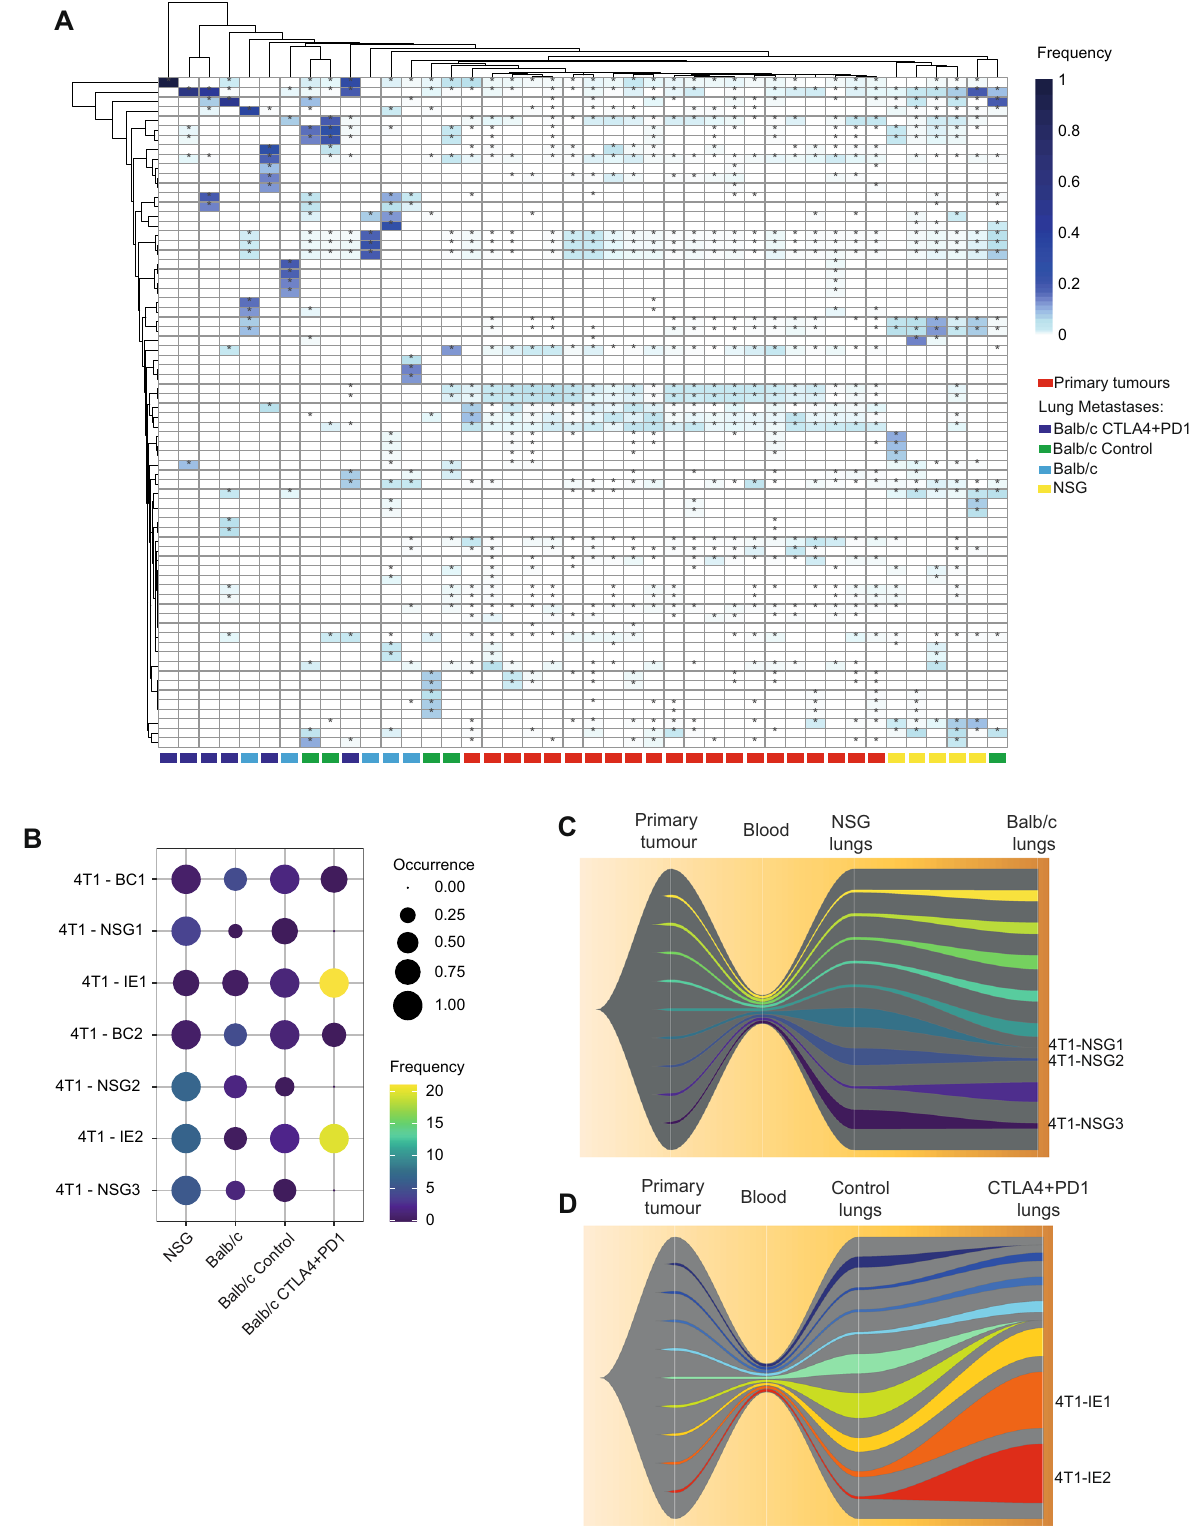
Fig. 4 | Analysis of speci fi c barcodes enriched or depleted by the immune system and immunotherapy in the 4T1 model. A Unsupervised hierarchical clustering heatmapofbarcodeswithanabundanceofabove5%inatleastone4T1primarytumourorlungmetastasissample;*indicatebarcodesdetectedatafrequencyabove0.1% inaparticularsample.Eachcolumnrepresentsasample(lungorprimarytumour)andeachrowrepresentsabarcode. B Dotplotofasubsetofspeci fi cbarcodes.Fivemice pergroup.Eachrowrepresentsabarcode.Eachcolumnrepresentsamousestrainortreatmentgroup. C Fishplotoftheninemostabundantbarcodesdetectedinlungsof WT and NSG mice, each of these nine barcodes is given a unique colour with the remaining barcodes being combined and represented in grey. A bottleneck has been introducedbetweenprimarytumourandlungmetastasestodepictthetransitionthroughthebloodstream. D Fishplotoftheninemostabundantbarcodesdetectedinthe lungsofWTmicetreatedwithcombinationimmunotherapyorcontrolantibodiespresentedasin C ,abottleneckhasbeenintroducedbetweenprimarytumourandlung metastases to depict transition through the bloodstream. Source data are provided as a source data fi